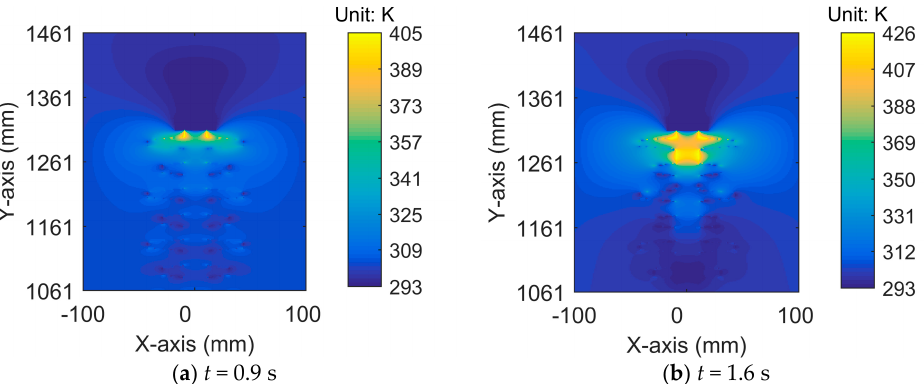
Figure 5. Thermal field distributions close to the high voltage (HV) electrode when the length of the dry band increases.